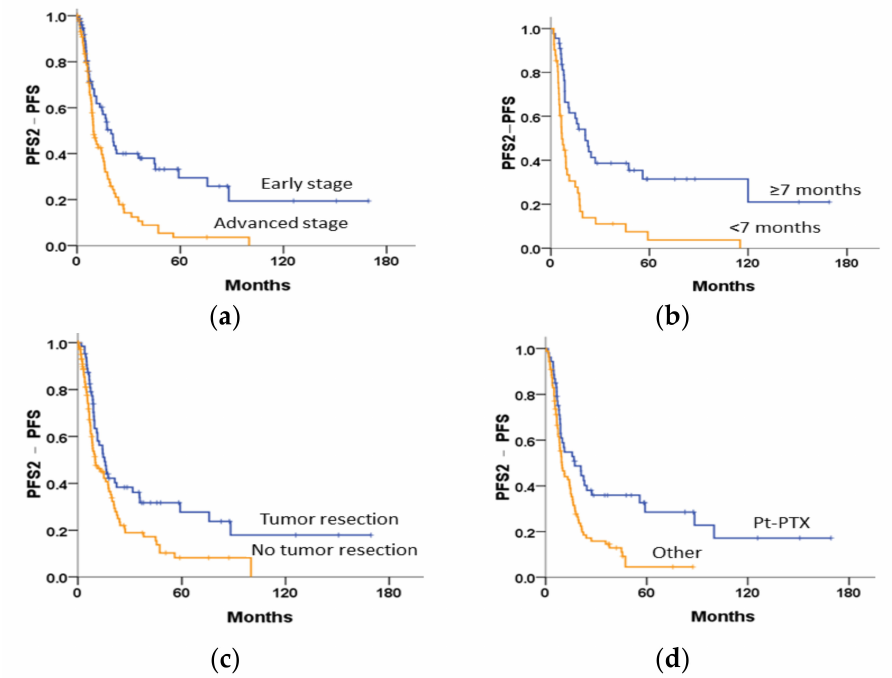
Figure 3. Kaplan–Meier curves. In the relapsed subgroup, PFS2-PFS was tested using the log-rank test, stratified by ( a ) stage ( p < 0.001), ( b ) progression-free interval of 7 months ( p < 0.001), ( c ) tumour resection ( p = 0.009), and ( d ) chemotherapeutic regimens for the first relapse ( p =